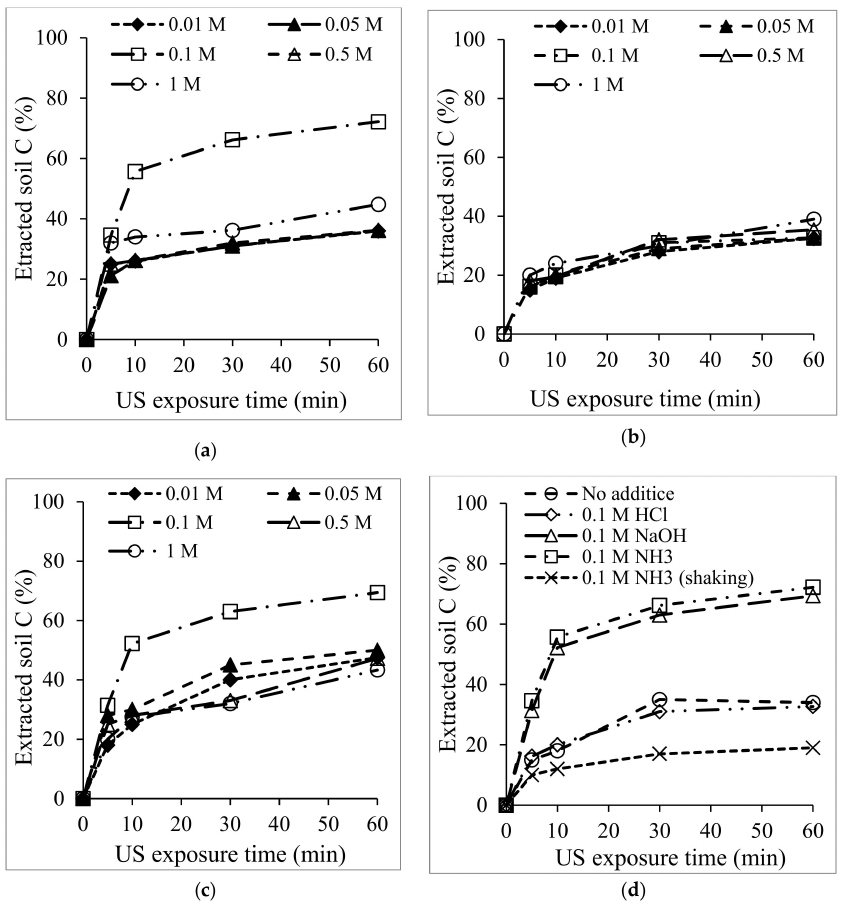
Figure 4. Calculated percentage of carbon extracted under 1200 W US exposure with 0.01–1 M concentration of ( a ) NH 3 , ( b ) HCl, ( c ) NaOH, and ( d ) shows a comparison of the US with no additive and 0.1 M concentration of various